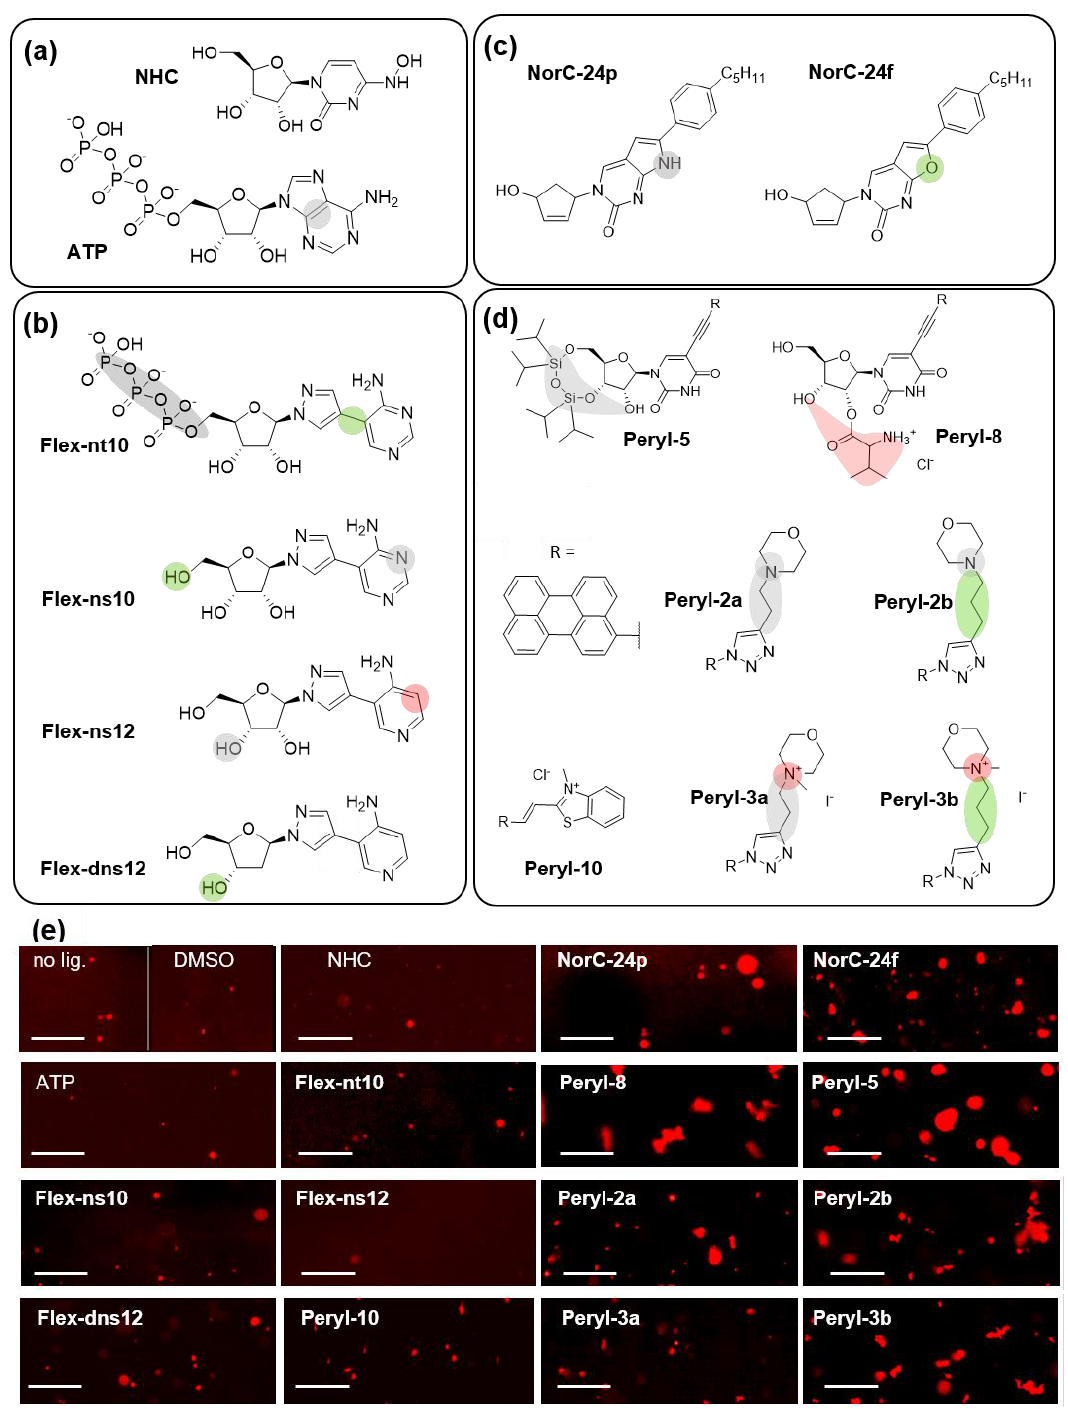
Figure 4. LLPS-modulating nucleoside analogs and perylene derivatives. ( a ) Control small molecules: N 4 -hydroxycitidine (NHC), control nucleoside-like antiviral; adenosine triphosphate (ATP), control LLPS modulator. ( b ) Fleximer (Flex) analogs of ATP, adenosine, and deoxyadenosine. ( c ) 5′ - Norcarbocyclic analogs of pyrimidine nucleosides. ( d ) Uridine analogs with perylene (Peryl) substituents in the nucleic base and non-nucleoside perylene derivatives. In each subset of the small molecules, modified residues are highlighted (grey). Those enhancing or inhibiting the formation of N-RNA condensates are marked with green or red, respectively. ( e ) Fluorescence microscopy images of the N-RNA mixtures (3 µM N and 6 µM SL5_long) after overnight incubation with 20 µM small molecule in 20 mM Tris-Cl, pH 7.4, at 37 °C. Scale bars: 10 µm.